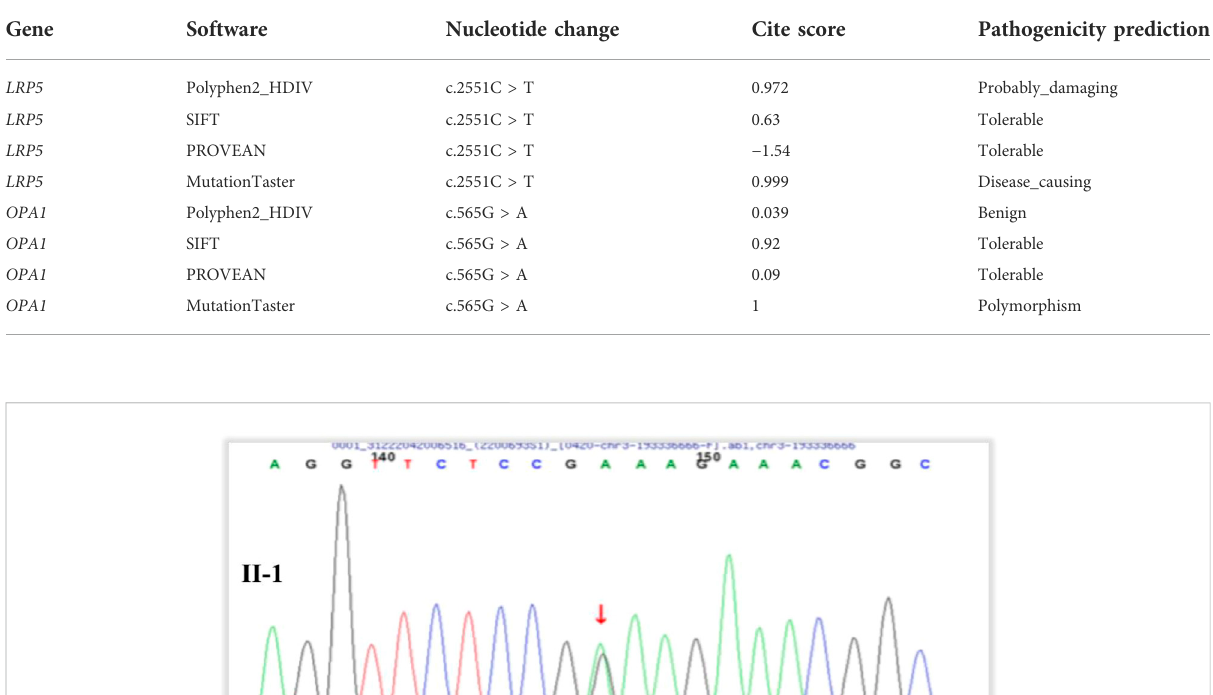
TABLE 1 Effect of LRP5/OPA1 mutation on protein function by different software applications.